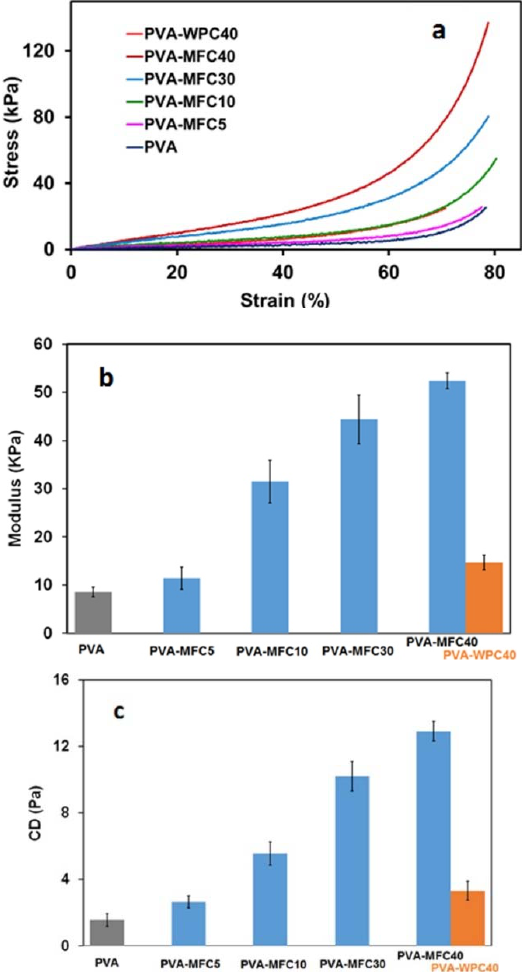
Figure 6. ( a ) Stress–strain curves; ( b ) compression moduli; and ( c ) compression deflection (CD) of PVA-based foams conditioned at 25 °C and 50% RH as a function of MFC and WPC amount.